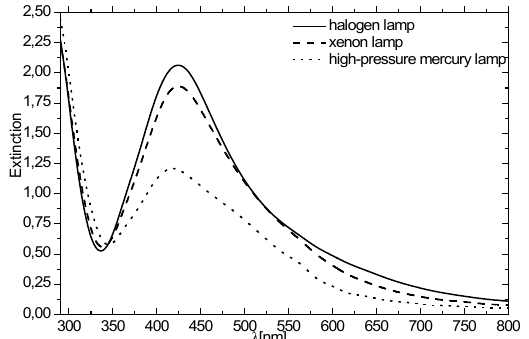
Figure 6. UV-Vis spectra recorded after 30 min of each AgBr photoreduction with ascorbic acid (molar ratio of AgBr to ascorbic acid 1:3.0, pH=10.0, in the presence of Na SO ) using exposure to radiation with various spectral 2 3 characteristics (halogen, xenon and high-pressure mercury